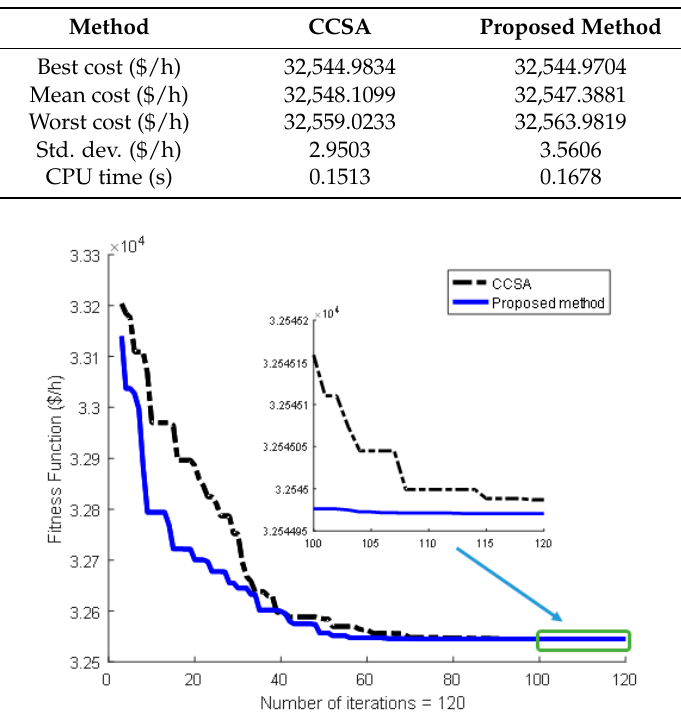
Figure 7. Fitness function curves iteration obtained by the CCSA and proposed method for case 2.